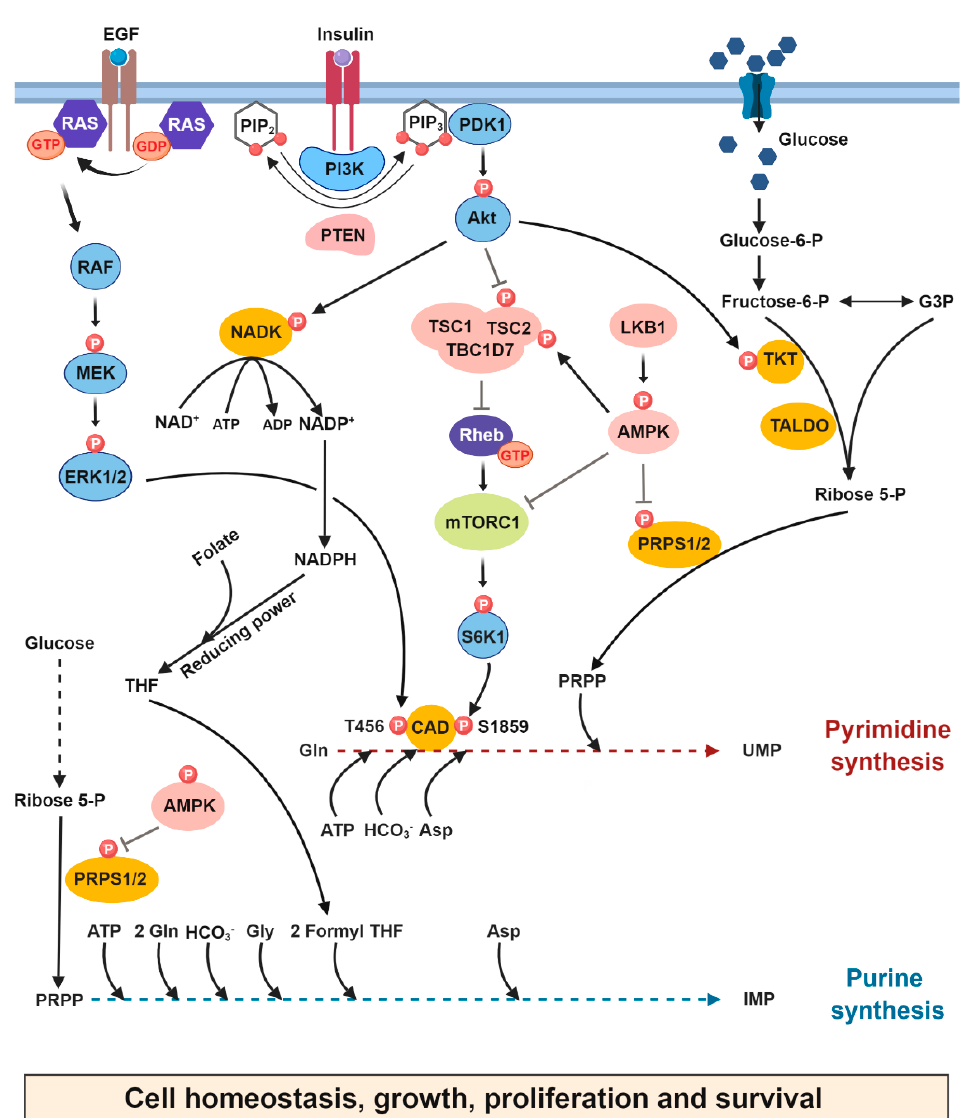
Figure 2. Acute regulation of de novo nucleotide synthesis by oncogenes and tumor suppressors. This schematic highlights our current understanding of how the oncogenic and tumor suppressor signals acutely modulate de novo nucleotide synthesis in cancer cells. In response to growth signals and activated oncogenic RAS, ERK directly phosphorylates CAD on T456 and stimulates de novo pyrimidine synthesis. In addition, mTORC1 activation, downstream of PI3K/Akt signaling, leads to S6K1 mediated-phosphorylation of CAD on S1859, thereby acutely enhancing flux through de novo pyrimidine synthesis. Upstream of mTORC1, Akt phosphorylates TKT on Thr382 and enhances PRPP availability for nucleotide synthesis. Moreover, Akt increases NADP + synthesis through the direct phosphorylation of NAD kinase on S44 / S46, thereby increasing the availability of cellular NADPH to sustain NADPH-dependent anabolic production of purine nucleotides. Under metabolic stress, AMPK is activated and directly phosphorylates PRPS1 / 2 on S180 / S183, which inhibits the conversion of ribose 5-phosphate into PRPP reducing its availability for nucleotide synthesis. Tumor suppressors are shown in pink, and key signaling kinases involved in light blue. Metabolic enzymes are shown in orange and small GTPases in dark blue. PRPP, 5’phosphoribosyl-pyrophosphate; PRPS, phosphoribosyl pyrophosphate synthetase; TKT, transketolase; AMPK, AMP-activated protein